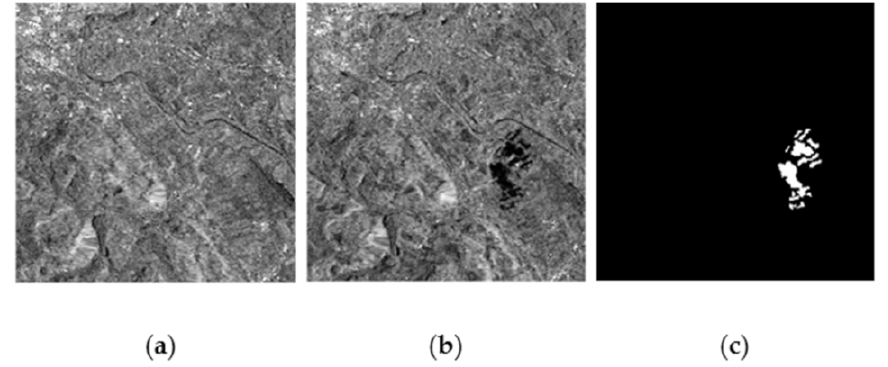
Figure 14. Bern dataset with a 30-m resolution. ( a ) Image acquired in April 1999. ( b ) Image acquired in May 1999. ( c ) Ground